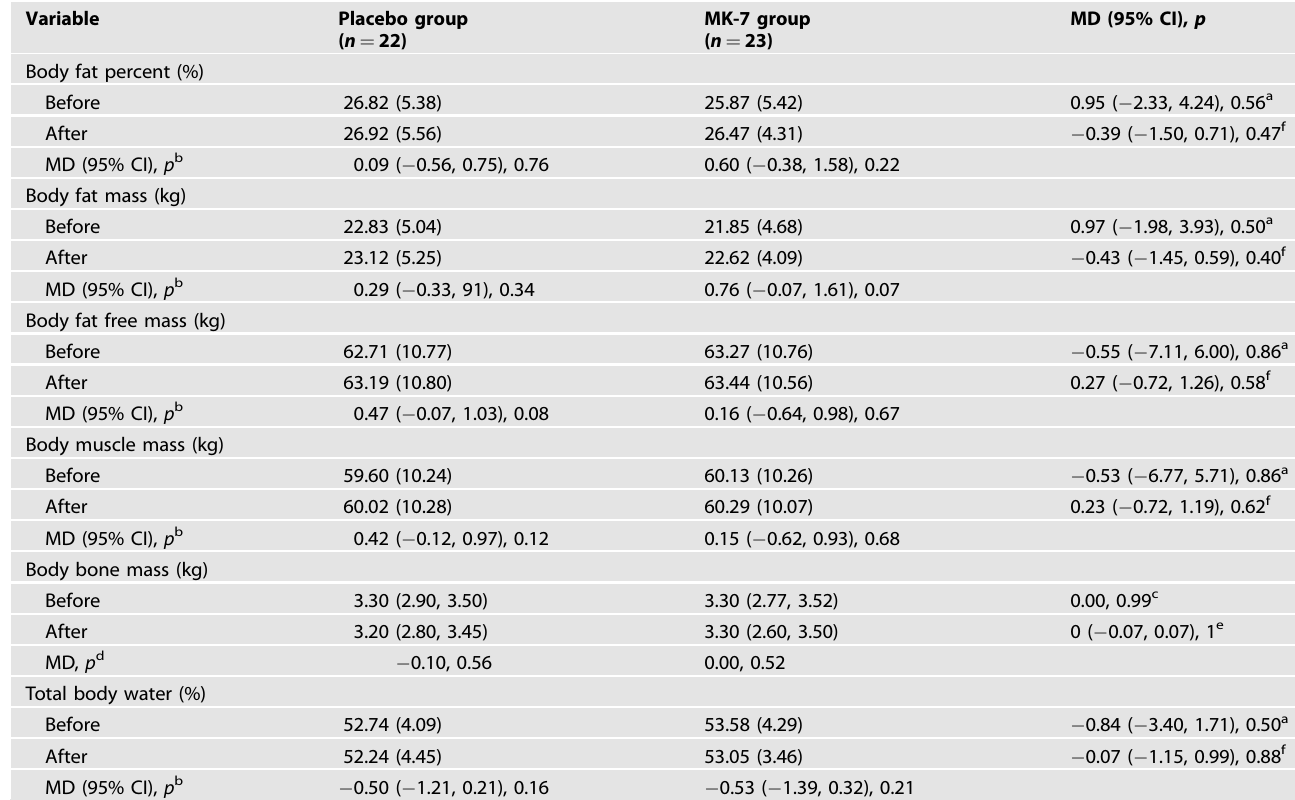
Table 3. Comparison of body composition between study groups at baseline and at the end of the